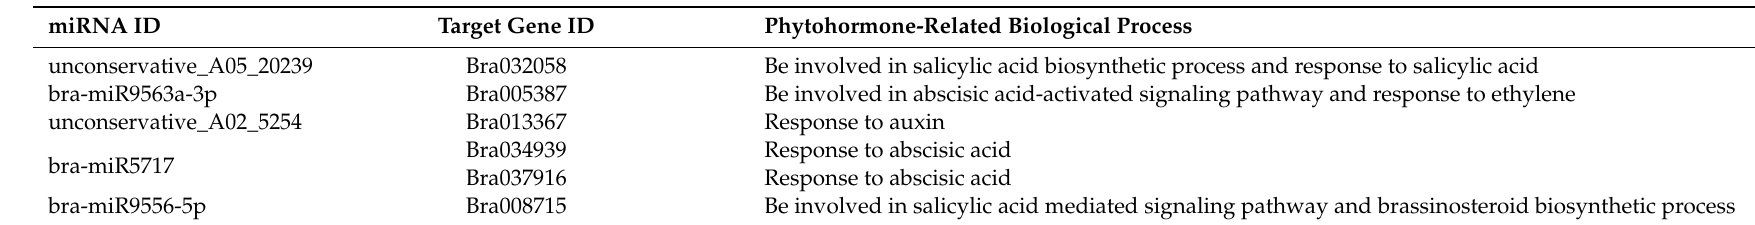
Table 7. miRNAs involved in the phytohormone-related biological process in Bcajh97-01B (fertile line) and Bcpol97-05A (sterile line) of Brassica